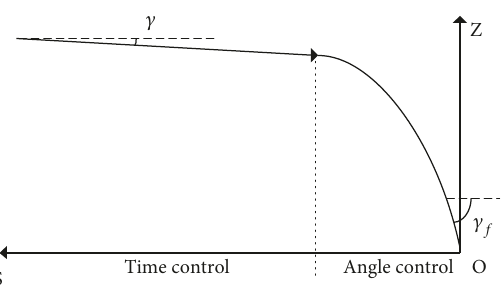
Figure 3: Division of vertical guidance